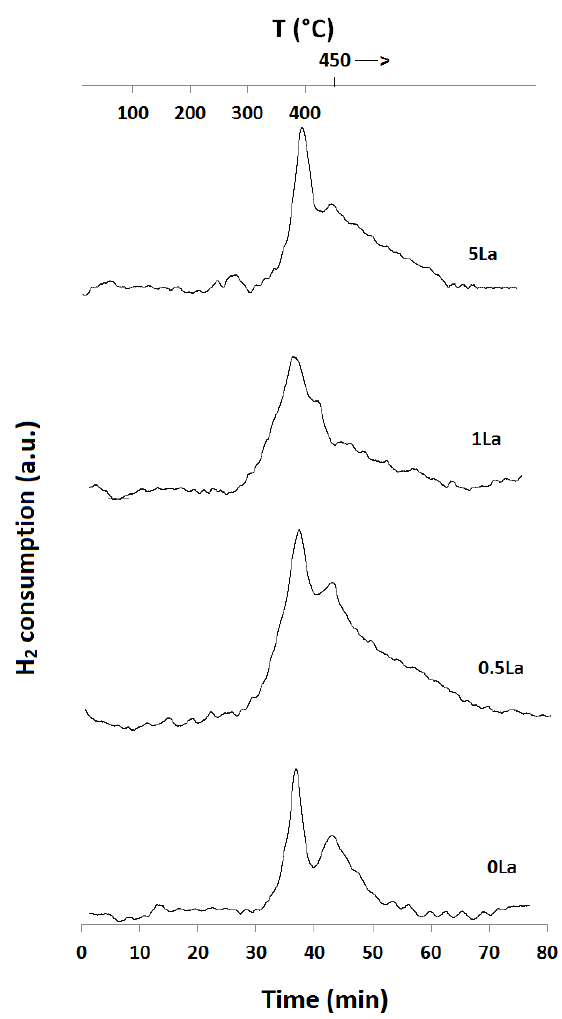
Figure 2. Second temperature-programmed reduction profiles of most of the catalysts (TPR 2, 10 mol % H2/Ar, total flow = 50 sccm, ramp rate = 10 °C/min). 0.5La catalyst has the highest hydrogen consumption.